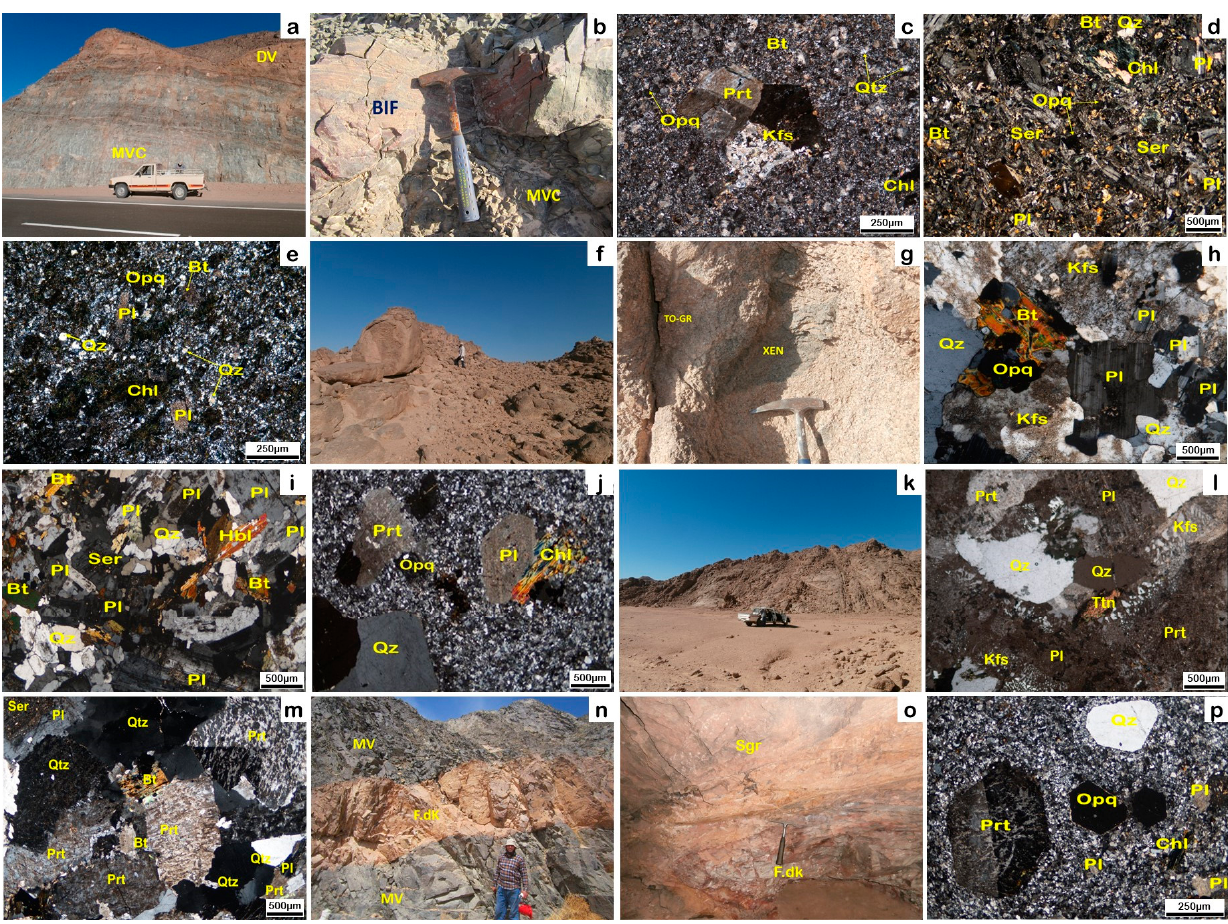
Figure 4. ( a ) Bedding and layering pattern of the metavolcaniclastics rocks (MVC) that intruded by Dokhan volcanics (DV) at Wadi Fatira Elbida (looking NW). ( b ) Metavolcaniclastics rocks include banded Iron Formation (BIF) at the northwestern slope of Gabal Magl Elrashayda. (Looking NW). ( c ) Kaolinized microperthite and quartz, biotite, and chlorite in metarhyolite. ( d ) Sericitized plagioclase, chlorite, and biotite in meta-andesite. ( e ) Altered plagioclase, quartz, biotite, chlorite, and opaques in the felsic metatuffs. ( f ) Exfoliation in synorogenic granitoid rocks (looking S). ( g ) Synorogenic granitoid rocks contain metavolcanic xenoliths (looking SW). ( h ) Quartz, plagioclase, microperthite, biotite, chlorite, sericite, kaolinite, and iron oxides in the granodiorite. ( i ) Tonalite has quartz and plagioclase, biotite, hornblende, and sericite. ( j ) Phenocrysts of altered plagioclase, kaolinized microperthite, chlorite, and quartz in a groundmass of quartz, plagioclase, chloritized biotite, kaolinized and sericitized feldspar, and iron oxides in rhyolite of Dokhan Volcanics. ( k ) Late to post-orogenic granitoid rock affected by joints (looking E). ( l ) Quartz and altered microperthite with plagioclase, and titanite in micrographic texture in the monzogranite. ( m ) Quartz, plagioclase, microperthite, muscovite, and iron oxides in monzogranite. ( n , o ) Felsite dike (F.dk) cut the metavolcanic rocks (MV) at Wadi Abu Zawal (looking NE). ( p ) Phenocrysts of kaolinized microperthite, chlorite, and quartz in a groundmass of quartz, plagioclase, chloritized biotite, kaolinized and sericitized feldspar, and iron oxides in felsite dike. Abbreviations: biotite (Bt); chlorite (Chl); K-feldspar (Kfs); hornblende (Hbl); kaolinite (Kln); microperthite (Prt); muscovite (Ms); opaque minerals (Opq); plagioclase (Pl); pyroxene (Py); quartz (Qtz and Qz); sericite (Ser); titanite (Ttn); tonalite-granodiorite (TO-GR); and xenolith (XEN).